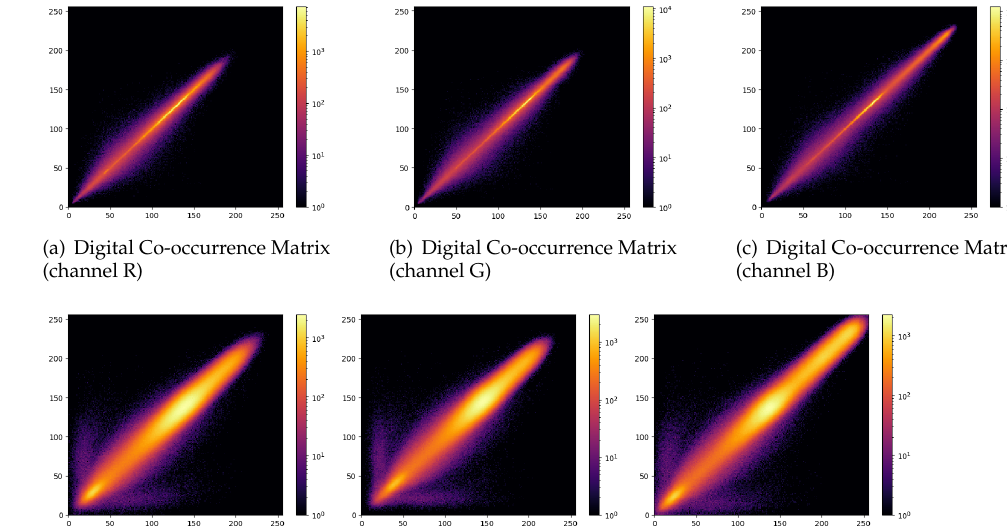
Figure 5. Zoomed regions of the same pictures in Figure 4.